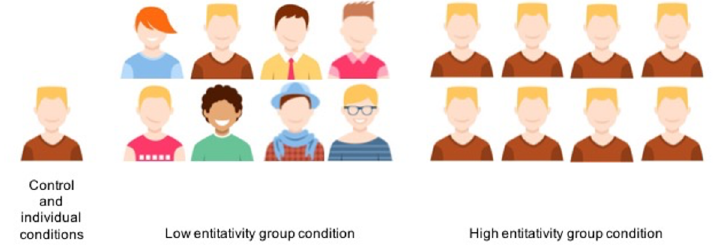
Fig 1. Pictures used along the descriptions of the punishment targets in every condition (Experiment